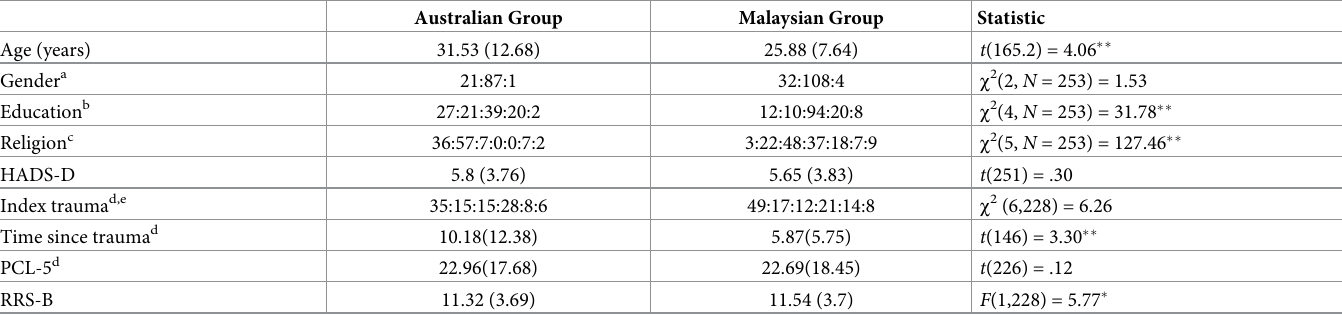
Table 1. Participant